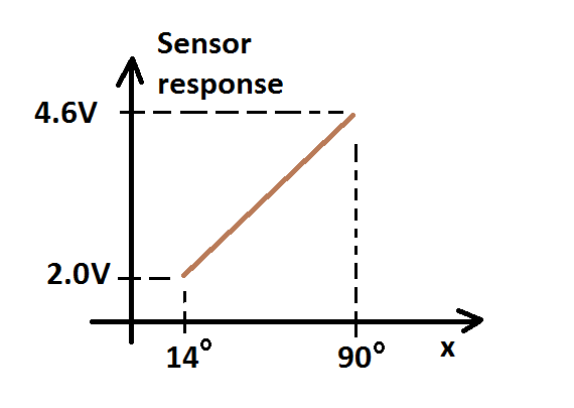
Figure 5. Sensor output versus throttle-plate angular position. When the throttle plate is completely open ( x = 90 degrees) the sensor output voltage is 4.6 V, and when the throttle-plate is closed (at x = 14 degrees), the related output is 2.0